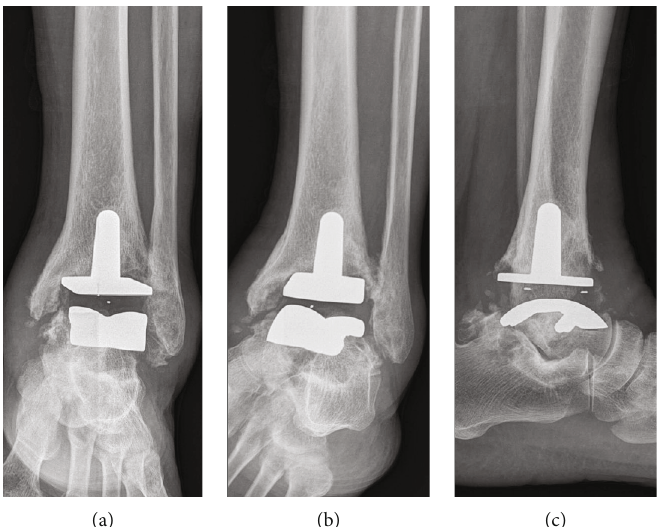
Figure 3: Six months after the TAA. (a, b) The radiological assessment revealed a progressive radiolucent line and osteolysis of the tibial component. (c) A lateral radiograph showed subsidence and a continuous radiolucency around the entire talar component.